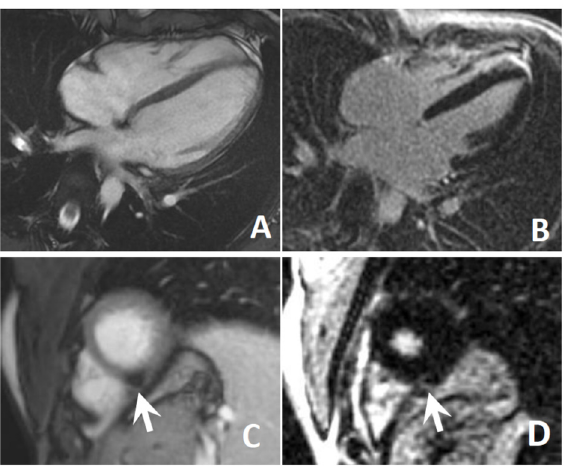
Figure 3. Top: Cardiac magnetic resonance four-chamber view showing normal biventricular vol- umes and wall thickness at cine steady-state free-precession ( A ) with no apparent areas of fibrosis at late gadolinium enhancement ( B ). Bottom: Short axis apical view showing a small, non-specific fibrofatty area in the distal interventricular septum appearing dark at cine steady-state free-precession sequences ( C ) and bright at late enhancement sequences ( D ).